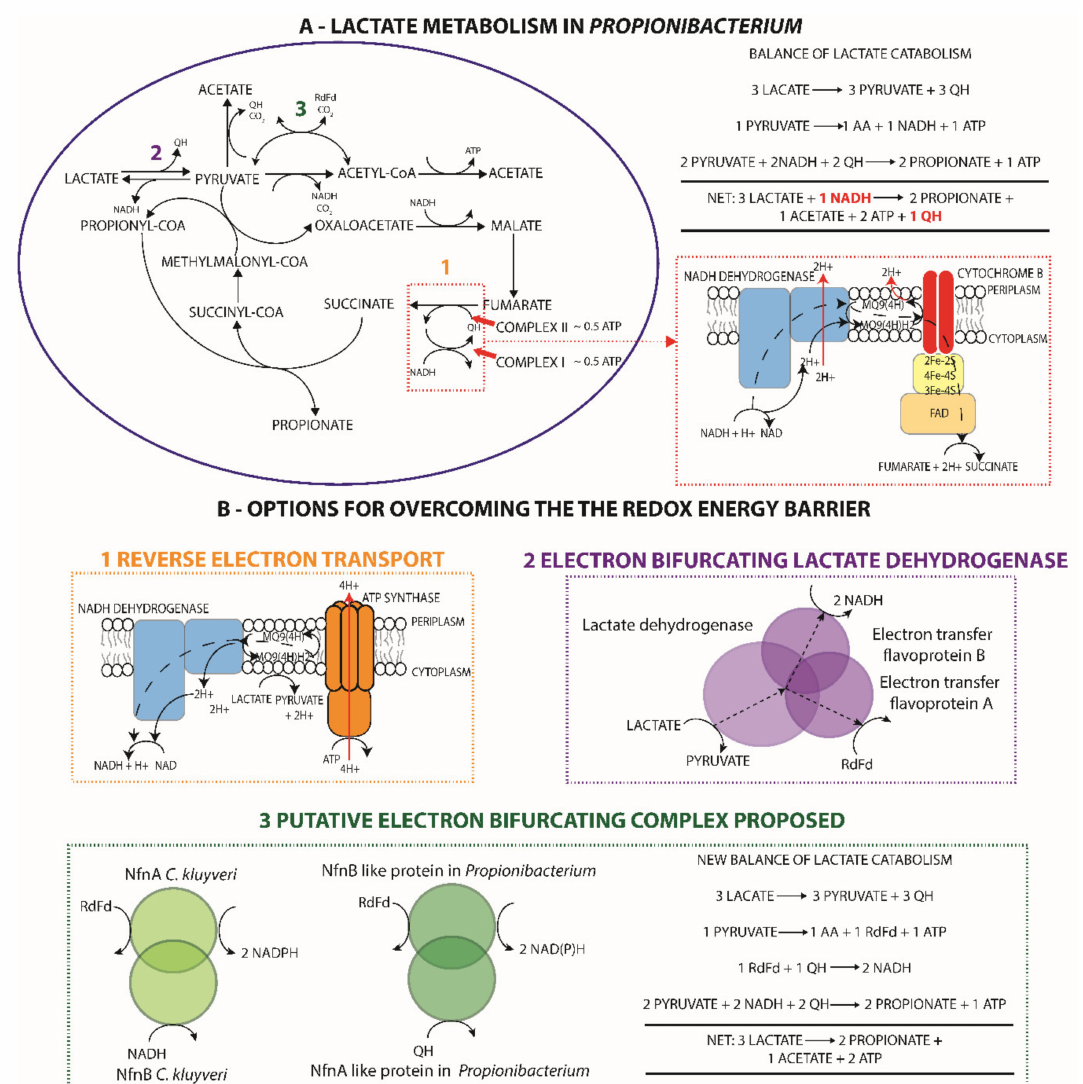
Figure 4. A novel ferredoxin-based energy conservation mechanism explains discrepancies between the literature and observed lactate metabolism in Propionibacterium . ( A ) Catabolic pathways for the conversion of lactate to propionate and acetate are illustrated and are most representative of the dairy propionibacteria, particularly P. acidipropionci , where the 2:1 ratio of propionate to acetate has been observed. The anaerobic electron transport chain is illustrated (bordered in red) and can be entered at complex II (cytochrome B) via quinols, presuming the translocation of two protons or half an ATP gain in energy, or complex I via NADH netting an additional two protons pumped. The balance over lactate catabolism illustrates that an overall redox imbalance exists where a quinol must be used to regenerate an NADH. ( B ) Potential strategies for overcoming this redox challenge are illustrated and are referenced to the appropriate location in metabolism in A. There was no genetic evidence for the first two mechanisms in propionibacteria; however, the last step is proposed based on similarities with flanking genes of the pyruvate ferredoxin oxidoreductase and the Nfn complex of Clostridium kluyveri , which could allow for the regeneration of NADH from a